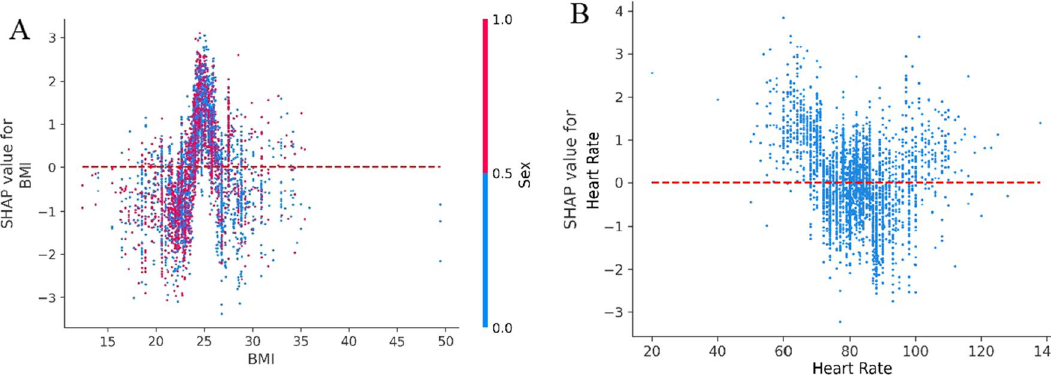
Figure 5. Partial SHAP dependence plots for BMI and heart rate. ( A ) BMI and gender interaction (red for male and blue for female). ( B ) Heart rate.